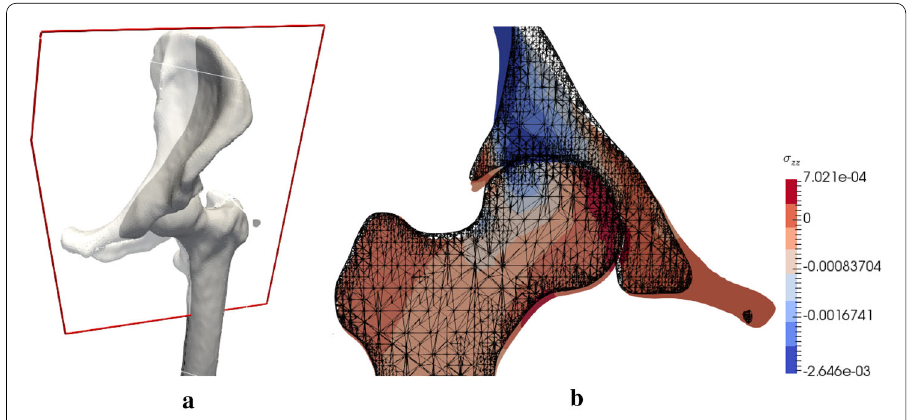
Fig. 12 Stress component σ zz ( b ) in slice of hip joint ( a ) together with its deformation ( b )